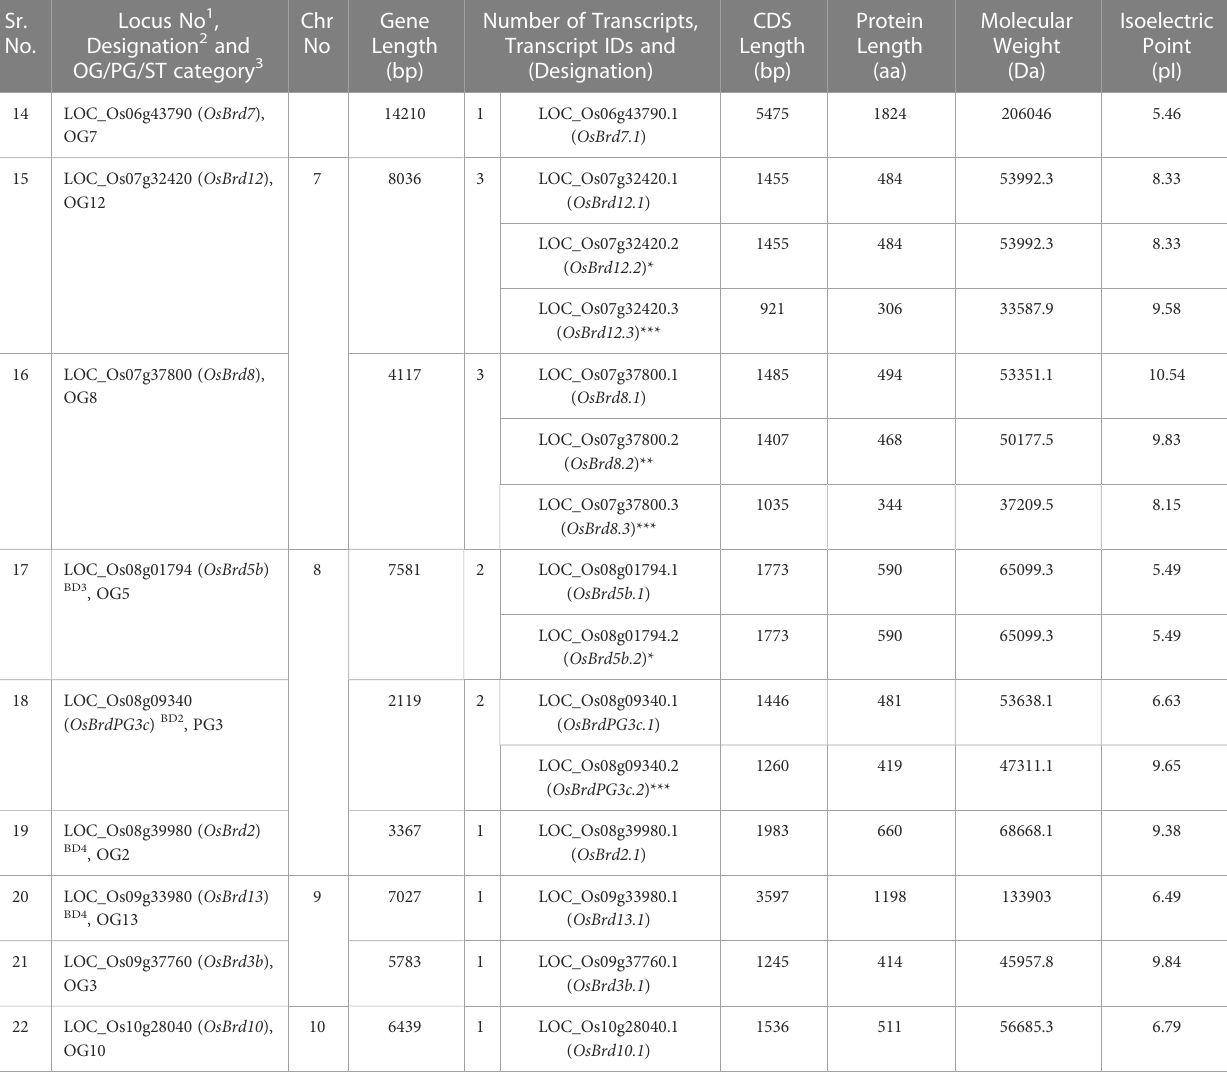
Figure 1C-xvi). Interestingly, OsBRD-members of duplication events BD1 (OsBRD4a-OsBRDST1) and BD4